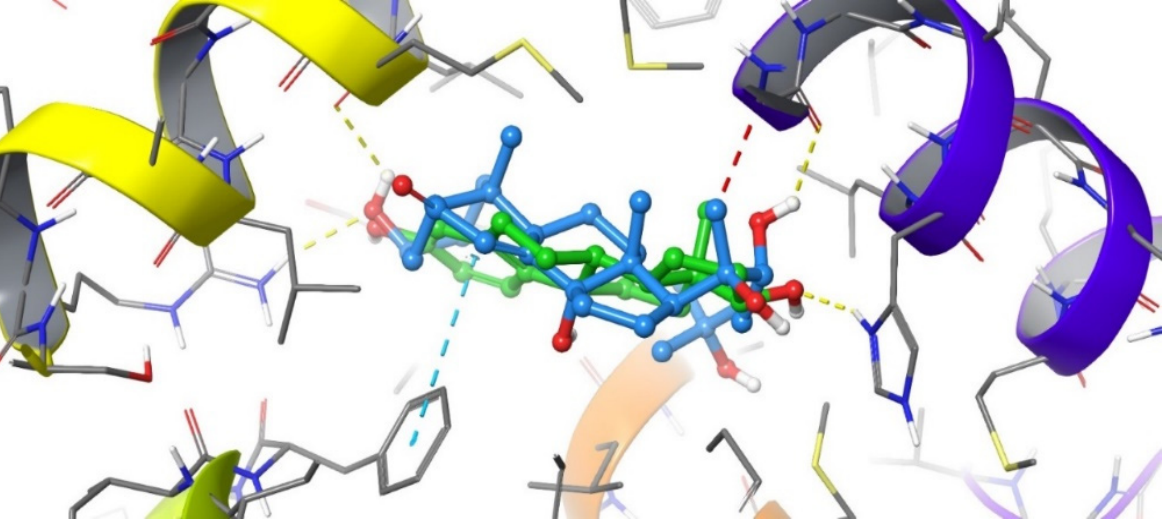
Figure 3. Overlay of the ligand 20-HE (cyan) and the co-crystallized ligand estradiol (green) in the binding cavity of ER β . Hydrogen bonds are displayed with yellow dashed lines, while steric clashes are displayed in red dashed lines.